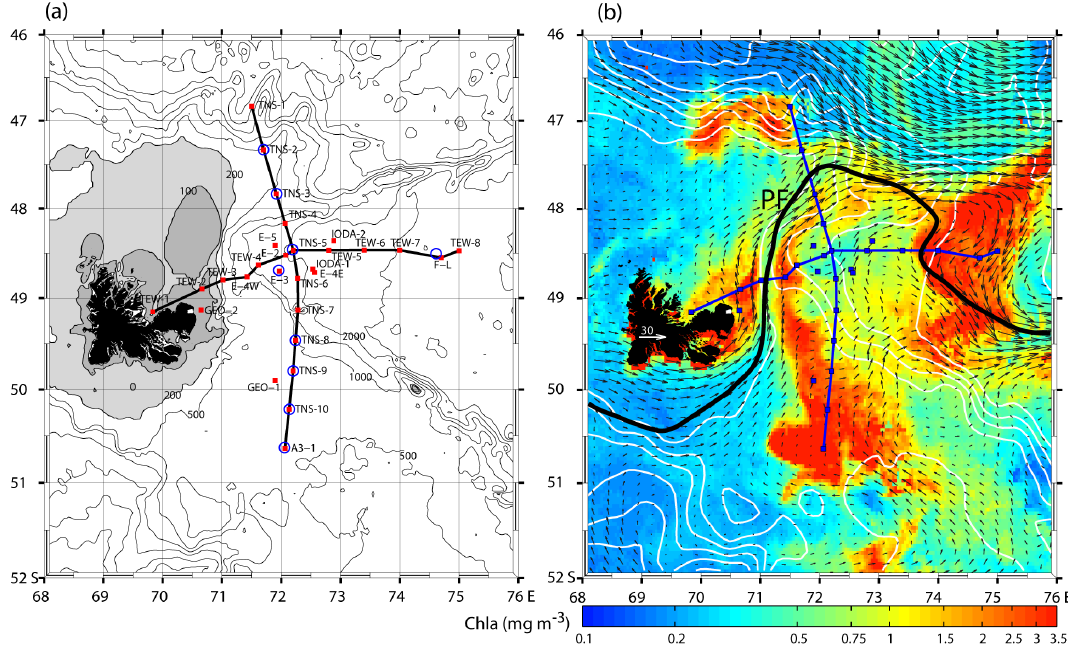
Figure 1. (a) Map showing the KEOPS2 CTD stations (red dots) on or close to two N–S and E–W transects superimposed on the detailed bathymetry. The concomitant TurboMAP microstructure profiler stations are indicated by blue circles. Isobaths greater than 500m are given every 500m and the seabed shallower than 200m (100m) is lightly (darkly) shaded. (b) These stations are also superimposed on a representative satellite image of chlorophyll concentration (colors) and a surface geostrophic velocity field (arrows) constructed from the combined data sets from altimetry and trajectories of drifters launched during the cruise. The geographical position of the polar front (PF) is indicated. This figure (b) has been adapted from Park et al.